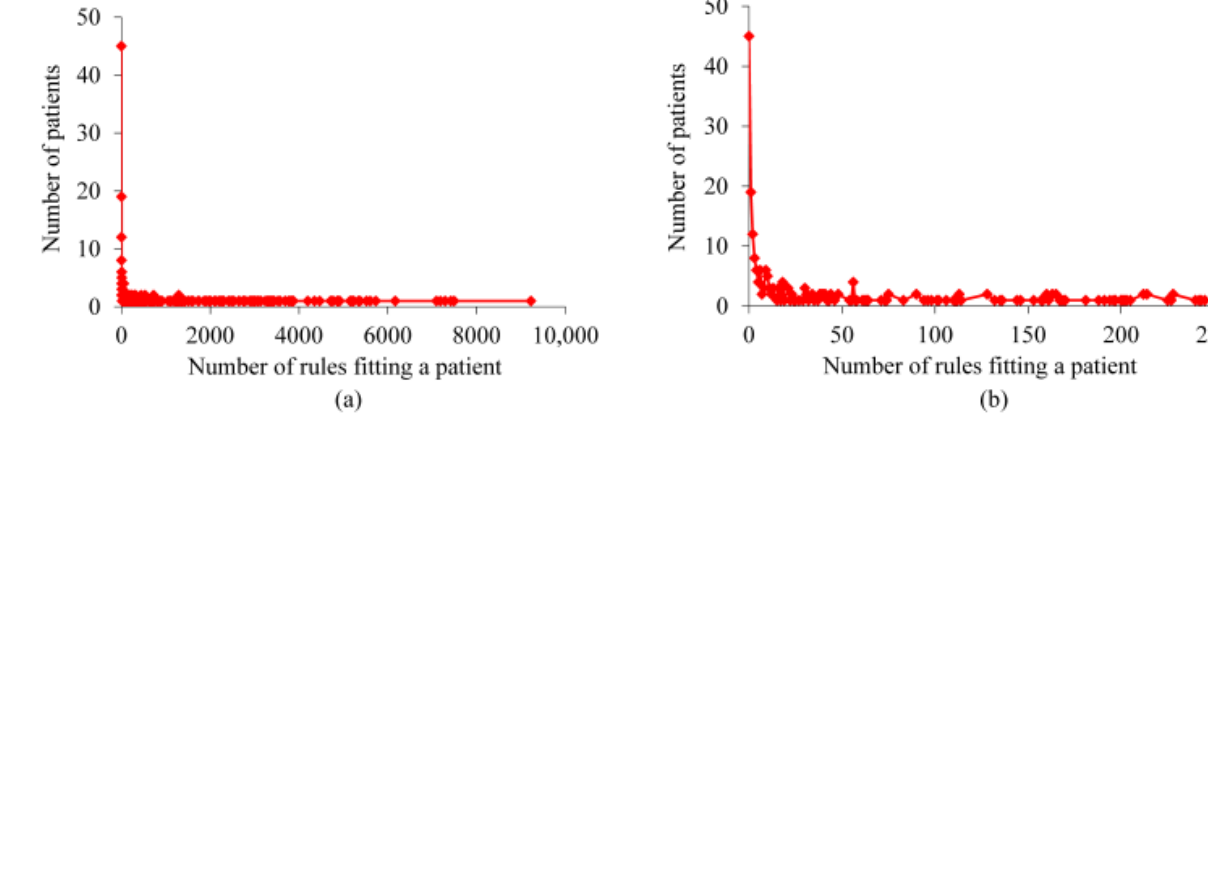
Figure 2. Distribution of patients by the number of rules fitting a patient for the patients with asthma whom our extreme gradient boosting model correctly predicted to incur asthma hospital visits in the subsequent year. (a) When no limit is placed on the number of rules fitting a patient. (b) When the number of rules fitting a patient is ≤